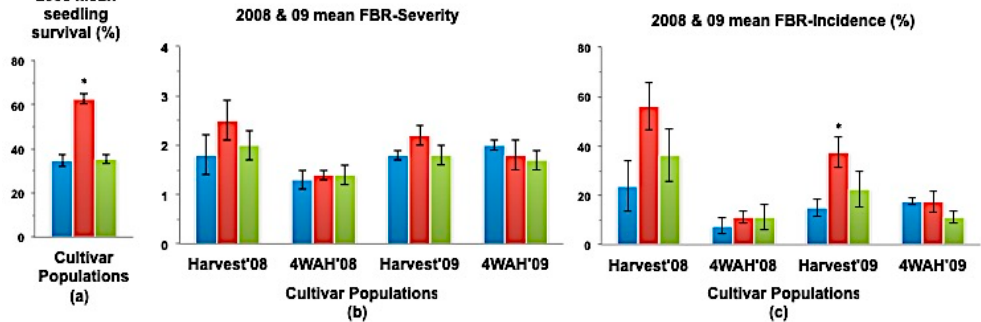
Figure 4. ( a ) Mean seedling survival; ( b ) Mean bulb FBR severity; and ( c ) Mean bulb FBR incidence (%) of NuMex Luna Ori, SS, and MBS populations in 2008 and 2009 evaluations. Std. error is shown on top of each bar. Grouping legend is provided in Figure 2. (*) Significantly different from original at P = 0.05.